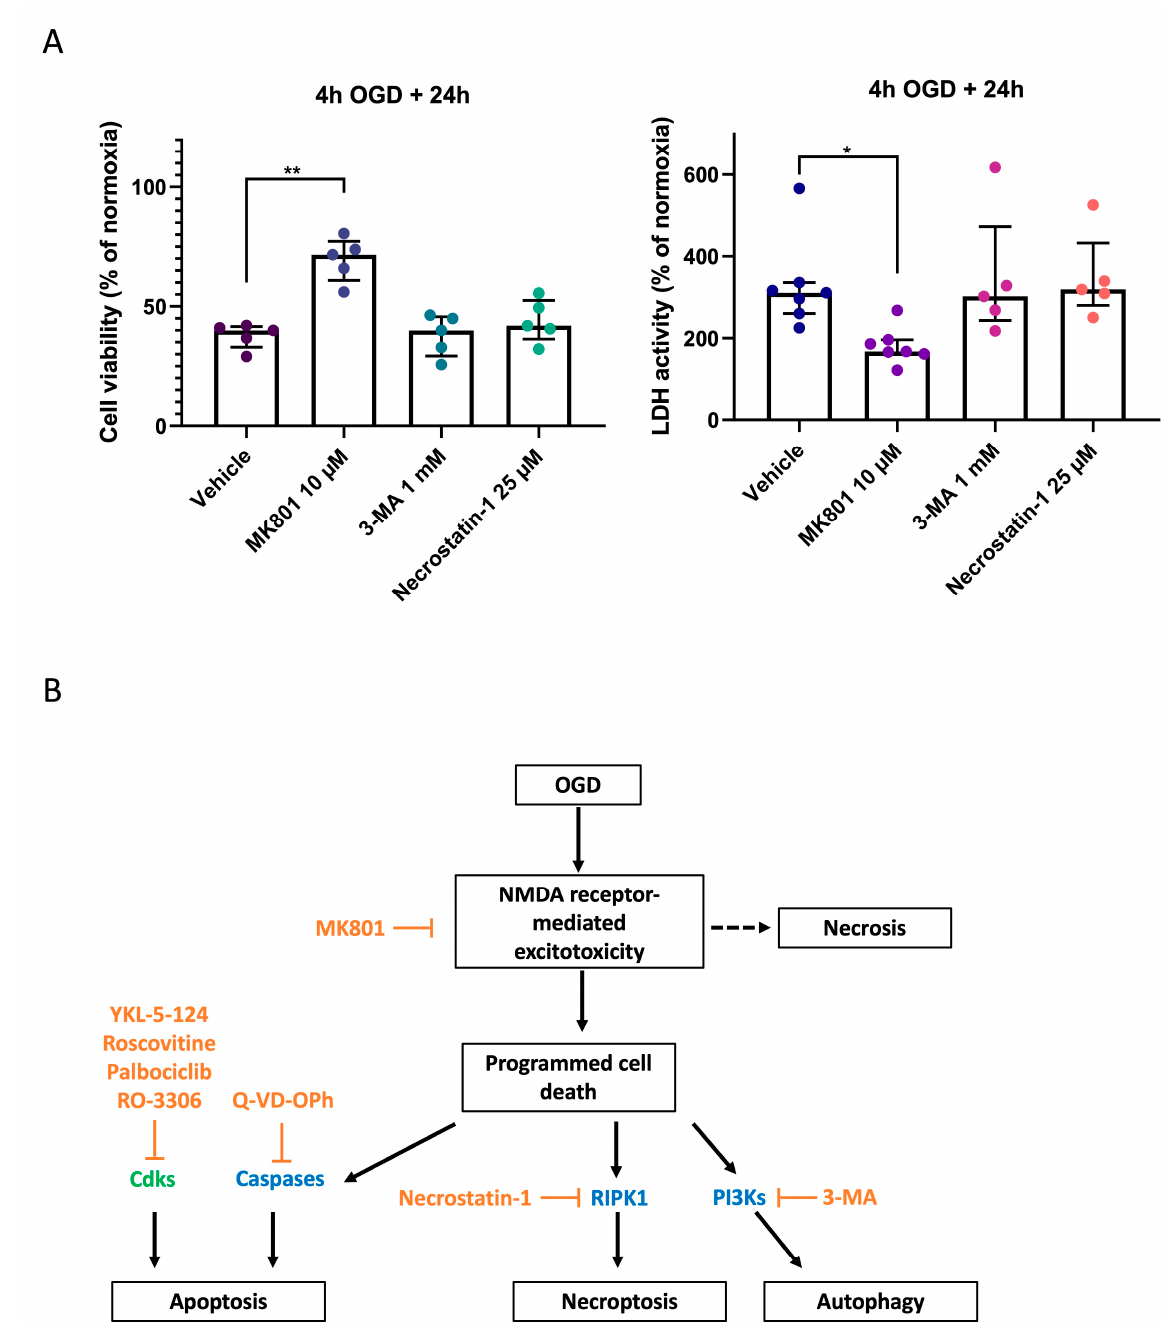
Figure 5. Pharmacological inhibition of autophagy and necroptosis does not prevent neurons from dying in response to OGD. ( A ) Viability of primary cortical neurons exposed to 4 h of OGD in the presence of either vehicle only (0.1% DMSO), MK801 (an NMDA receptor antagonist), 3-MA (an autophagy inhibitor), or necrostatin-1 (an inhibitor of necroptosis). Viability was measured with the CCK8 assay (left), while cytotoxicity was quantified using the LDH assay (right). Values are expressed as a percentage of the normoxia condition, measured 24 h after the end of OGD. Each dot represents the mean value of 4 replicates for a unique batch of primary cortical neurons (each batch is obtained from a separate pregnant mouse). Groups were compared using Kruskal–Wallis test with Dunn’s multiple comparisons test. Error bars: interquartile range. * p ≤ 0.05; ** p ≤ 0.01. ( B ) Scheme of the hypothetic pathways involved in neuronal cell death following OGD.